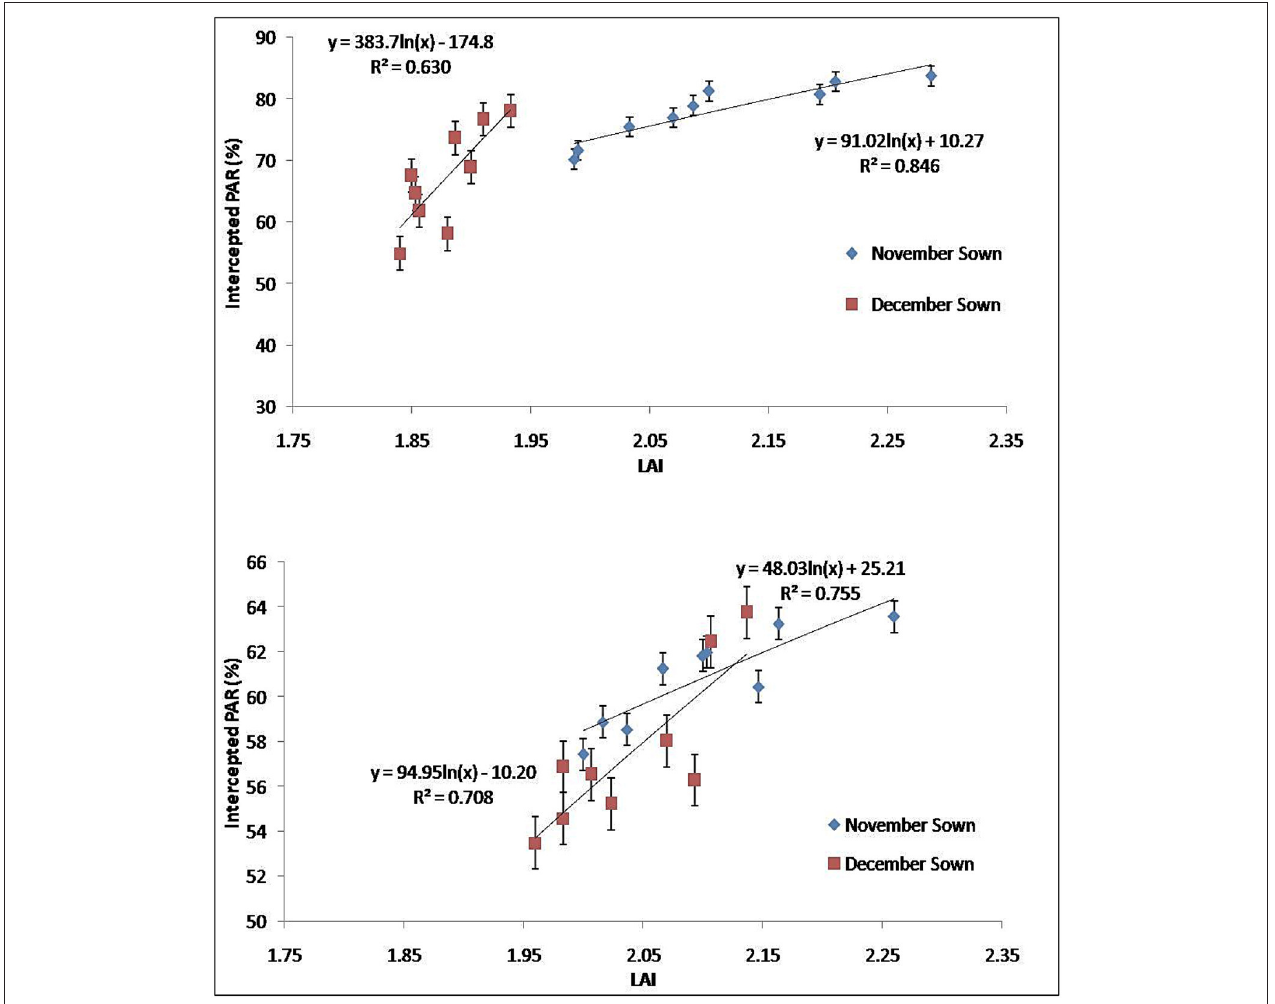
FIGURE 8 | PARUE at the reproductive stage (75–90 DAS) under different dates of sowing and foliar spray (data of 2018–2019 and 2019–2020 crop seasons) (error bars represent the standard error of mean).